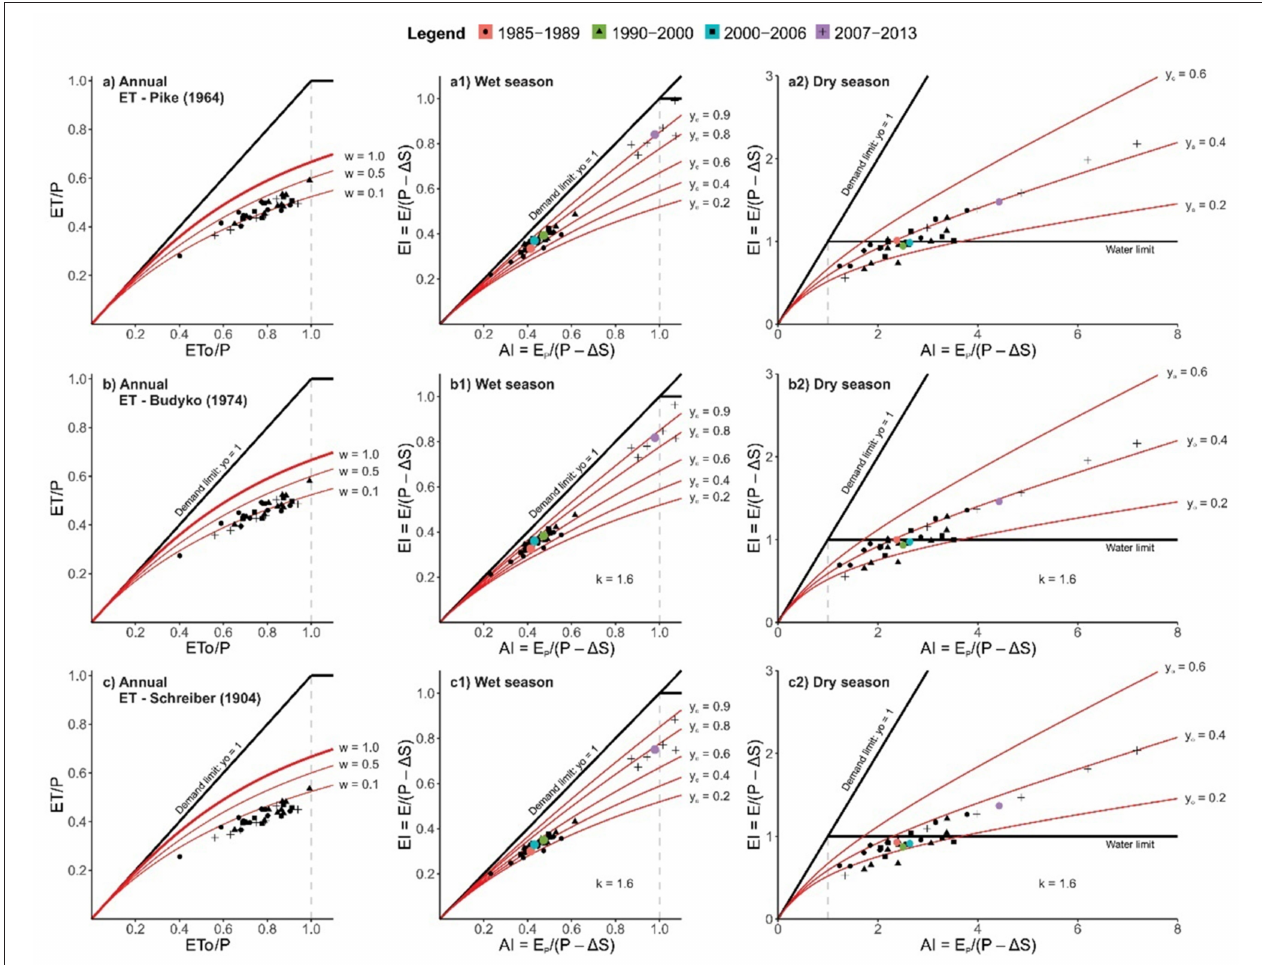
FIGURE 5 | Left, relationship of AI (ET o /P) vs. EI (ET/P) on the annual scale for different w values, according to Pike (a) , Budyko (b) , and Schreiber (c) for the IRW (1980–2013). ET is the actual evapotranspiration, P is the precipitation, and Ep equals potential evapotranspiration (ET o ). In the center and to the right, the